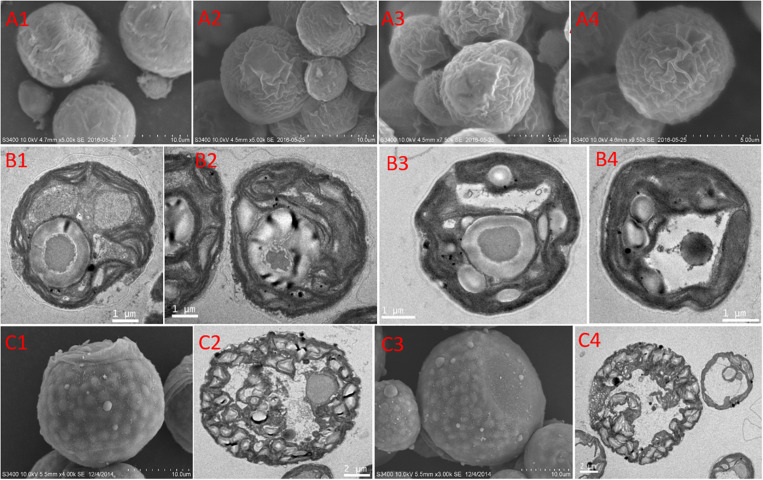
Morphological characteristics of Symbiochlorum hainanensis in response to acidification and warming. Scanning electron microscopic presentations of the vegetative cells of S. hainanensis under the control (A1), elevated temperature (A2), acidification (A3), and combined treatment (A4). Transmission electron microscopic presentations of vegetative cells of S. hainanensis under the control (B1), elevated temperature (B2), acidification (B3), and combined treatment (B4). Scanning and transmission electron microscopic presentations of aplanosporangiums of S. hainanensis under acidification conditions (C1–C4).